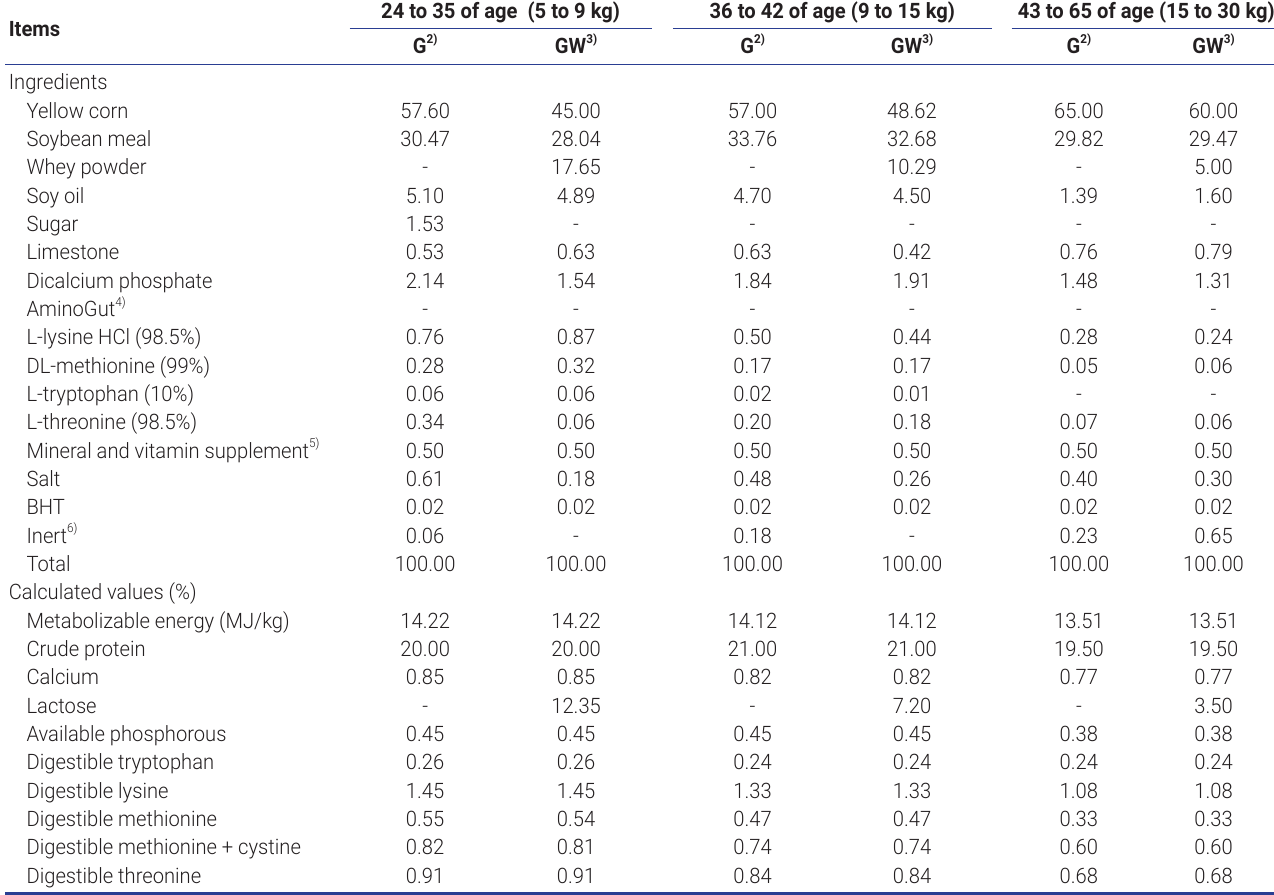
Table 1. Ingredients and chemical composition of the diets for piglets